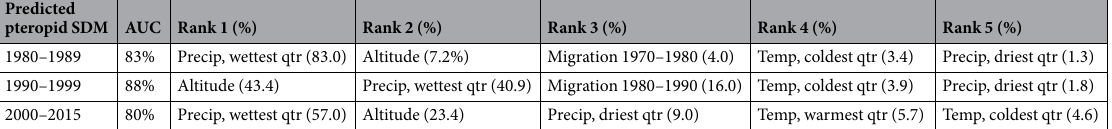
Table 1. Description of the ecologic niche models for Hendra reservoir Pteropus species for each decade 1980–1989, 1990–1999, and 2000–2015, respectively. For each model the area under the curve (AUC) is presented to describe model performance, and the ranking of the top five landscape features defining the ecologic niche are listed with their respective relative influences reported as a percentage in parentheses. The rank order is determined by the magnitude of the relative influence. Precipitation (Precip) during the driest and wettest quarters (qtr), and temperature (Temp) during the warmest and coldest quarters represent the mean measurements during these quarters over the period 1950 to 2000. Migration represents the net human migration per 1 km 2 during the previous decade.